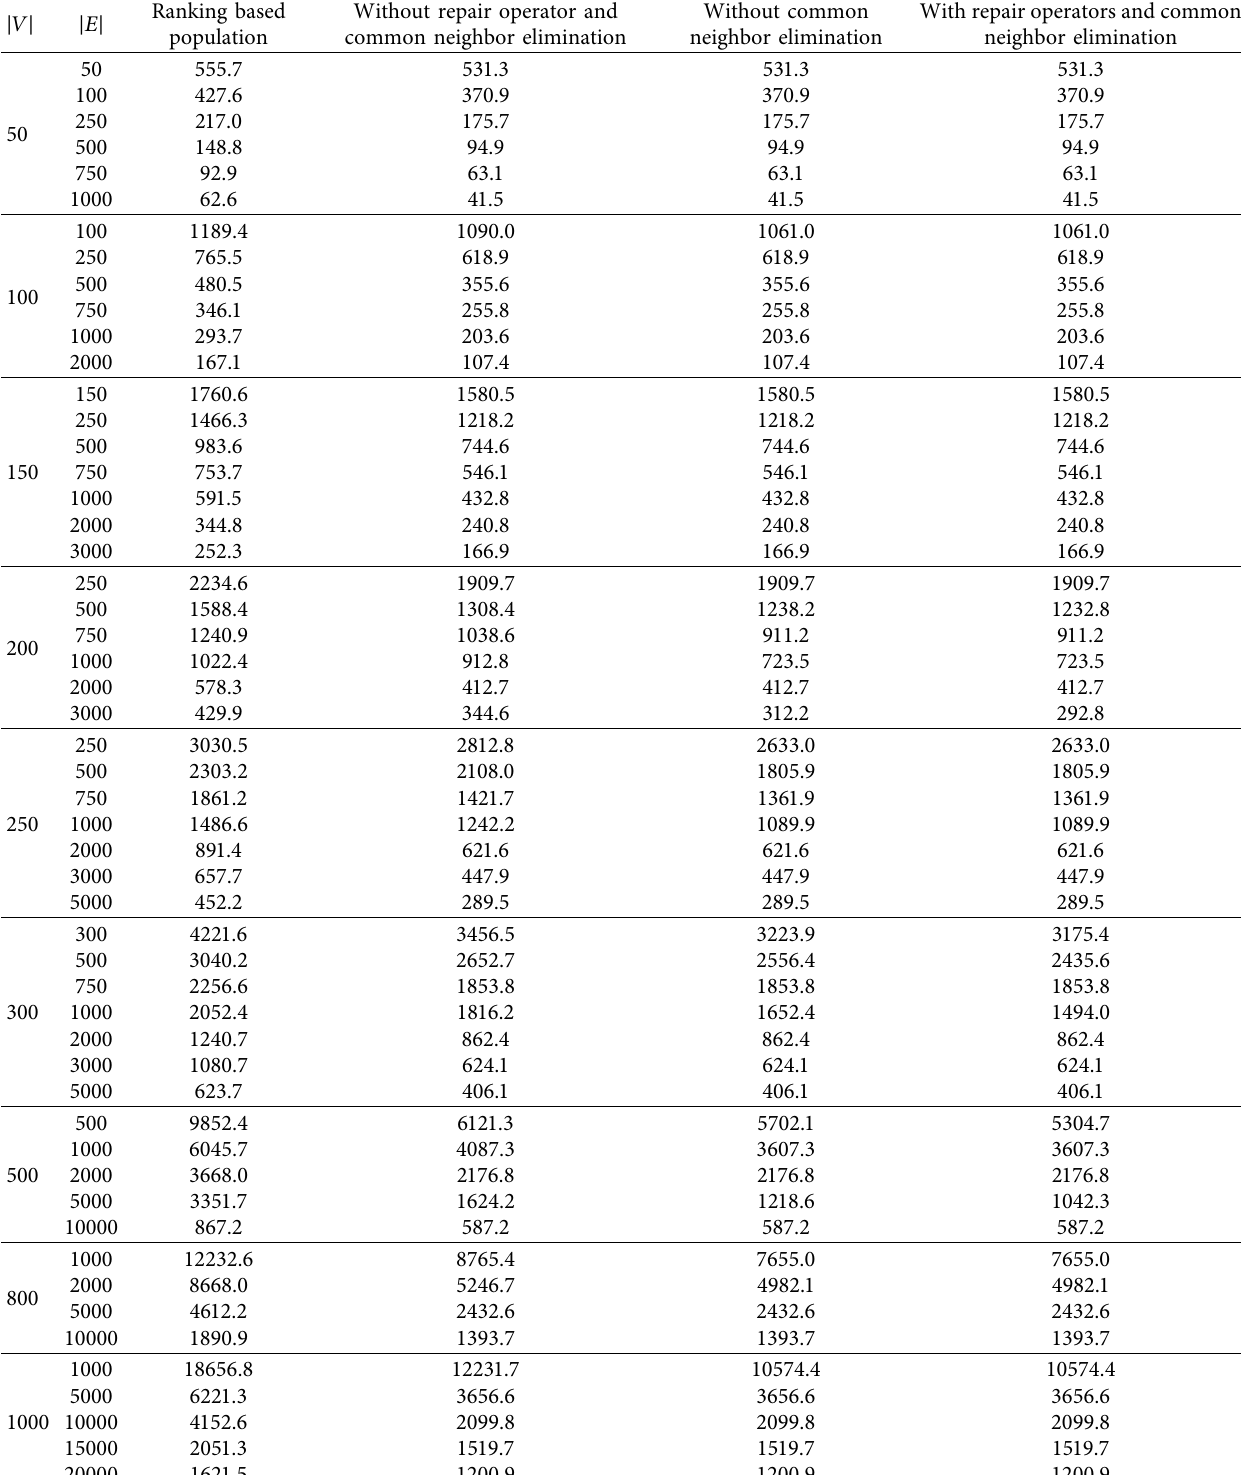
Table 12: Type TI comparison of MWDS_CRO for diferent